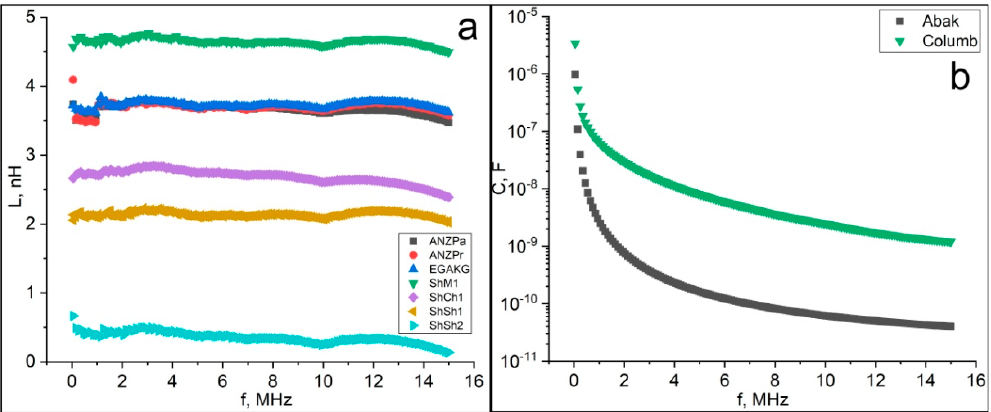
Figure 13. Frequency dependence of inductance ( a ) and capacitance ( b ). Sample code is similar to Figure 12.